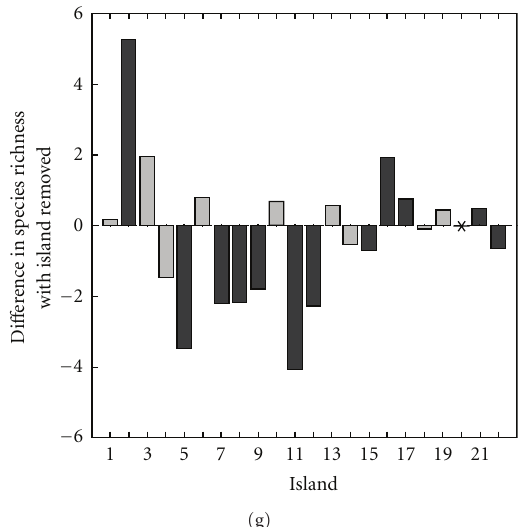
Figure 4: Changes in native plant species richness when islands are removed from the archipelago. Islands removed were (a) Isabela, (b) Santa Cruz, (c) Santiago, (d) San Cristobal, (e) Pinta, (f) Daphne, and (g) Tortuga. Darkly shaded bars are di ff erences greater than one standard error of zero. Islands numbers are (1) Isabela, (2) Santa Cruz, (3) Fernandina, (4) Santiago, (5) San Cristobal, (6) Floreana, (7) Marchena, (8) Pinta, (9) Espa˜nola, (10) Balta, (11) Santa F´e, (12) Pinz´on, (13) Genovesa, (14) R´abida, (15) Wolf, (16) Darwin, (17) Seymore, (18) Daphne, (19) Bartolom´e, (20) Tortuga, (21) Gardner-Floreana, and (22)